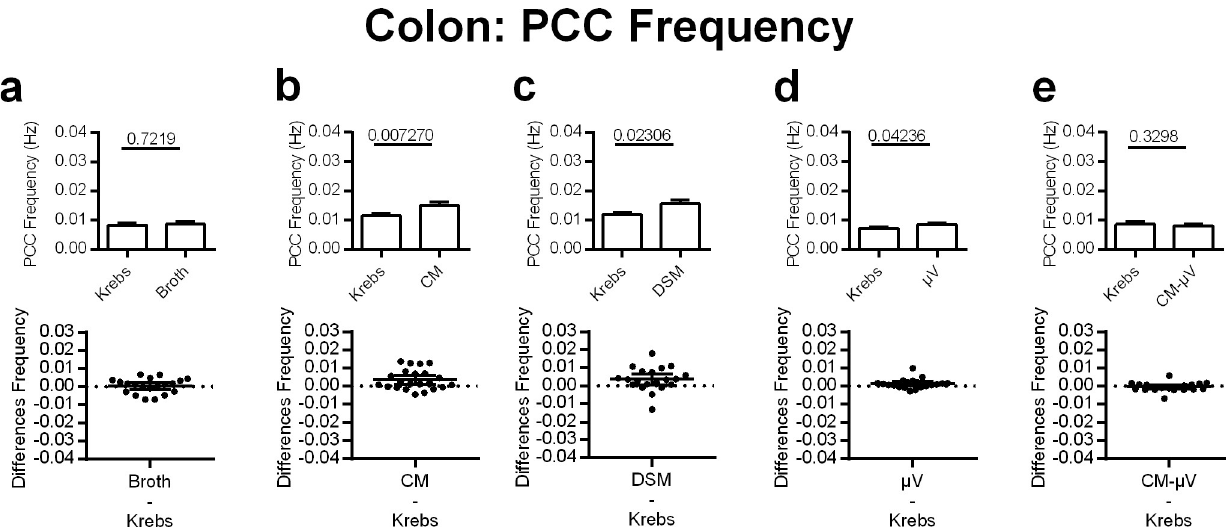
Fig 6. Effects of adding DSM, μ V or media on PCC frequency for mouse colon segments, in vitro . c) DSM (N = 20), b) CM (N = 28) and d) μ V (N = 20) increased PCC frequency. a) broth (N = 20) or e) CM- μ V (N = 20) had no statistically significant effects on PCC frequency. P values derived from paired t- tests are given above horizontal bars. Significance determined when p <